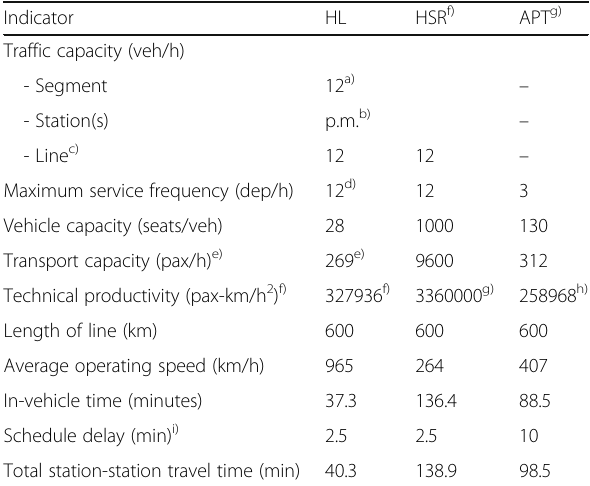
Table 2 Some estimates of the indicators of operational performances of the HL system and its counterparts - HSR